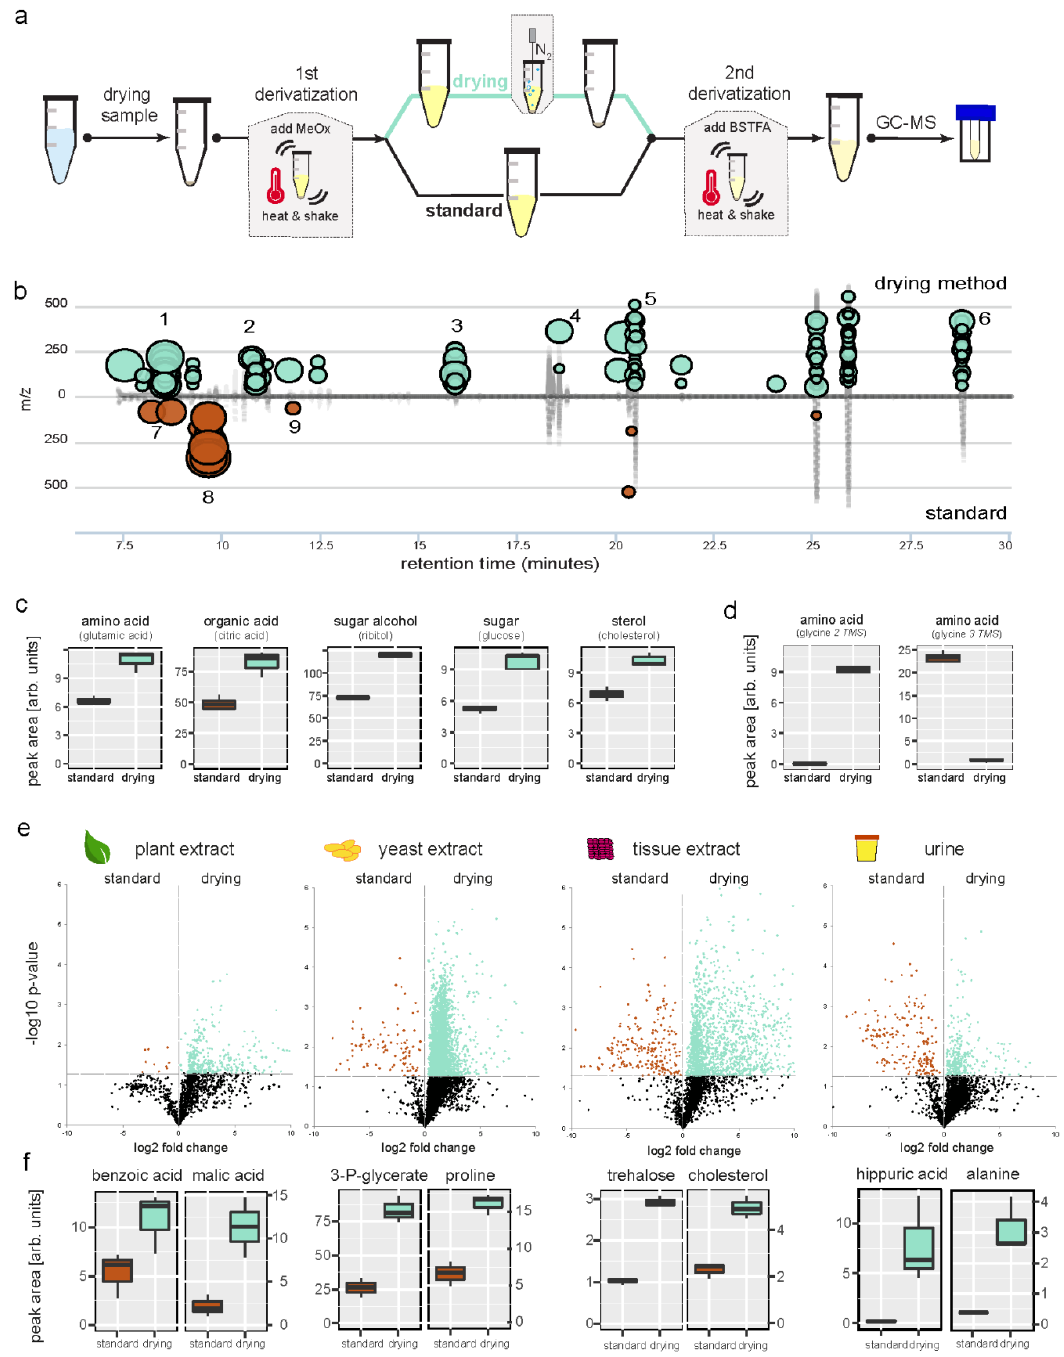
Figure 1. Enhanced metabolite signals by implementing a drying step into global metabolomics GC–MS derivatization. ( a ) Drying derivatization method in comparison with the standard sample preparation scheme. ( b ) Synthetic metabolite mixture showing increased peaks using the drying method against the standard method visualized via chromatographic cloud plot (XCMS). ‘Bubbles’ indicate significantly changed features between tested methods (>1.5 fold change; p < 0.05, Welch t -test). Increased metabolites (green) are alanine,1; valine, 2; glutamic acid, 3; citric acid, 4; glucose, 5; cholesterol, 6. Decreased peaks (red) are derivatization side products, 7 and 8; glycine 3TMS, 9 (see Supplementary Figure S2 for identifications). ( c ) Enhanced signal area for metabolites of synthetic metabolite mixture using the drying method. ( d ) Derivatization (trimethylsilylation) product is changing for glycine using the drying method. ( e ) Metabolome wide signal enhancement in plant-, yeast cell-, tissue, and urine samples. Comparing fold changes of all detected GC – MS features, standard method against the drying method. Each sample type was analyzed in triplicates using